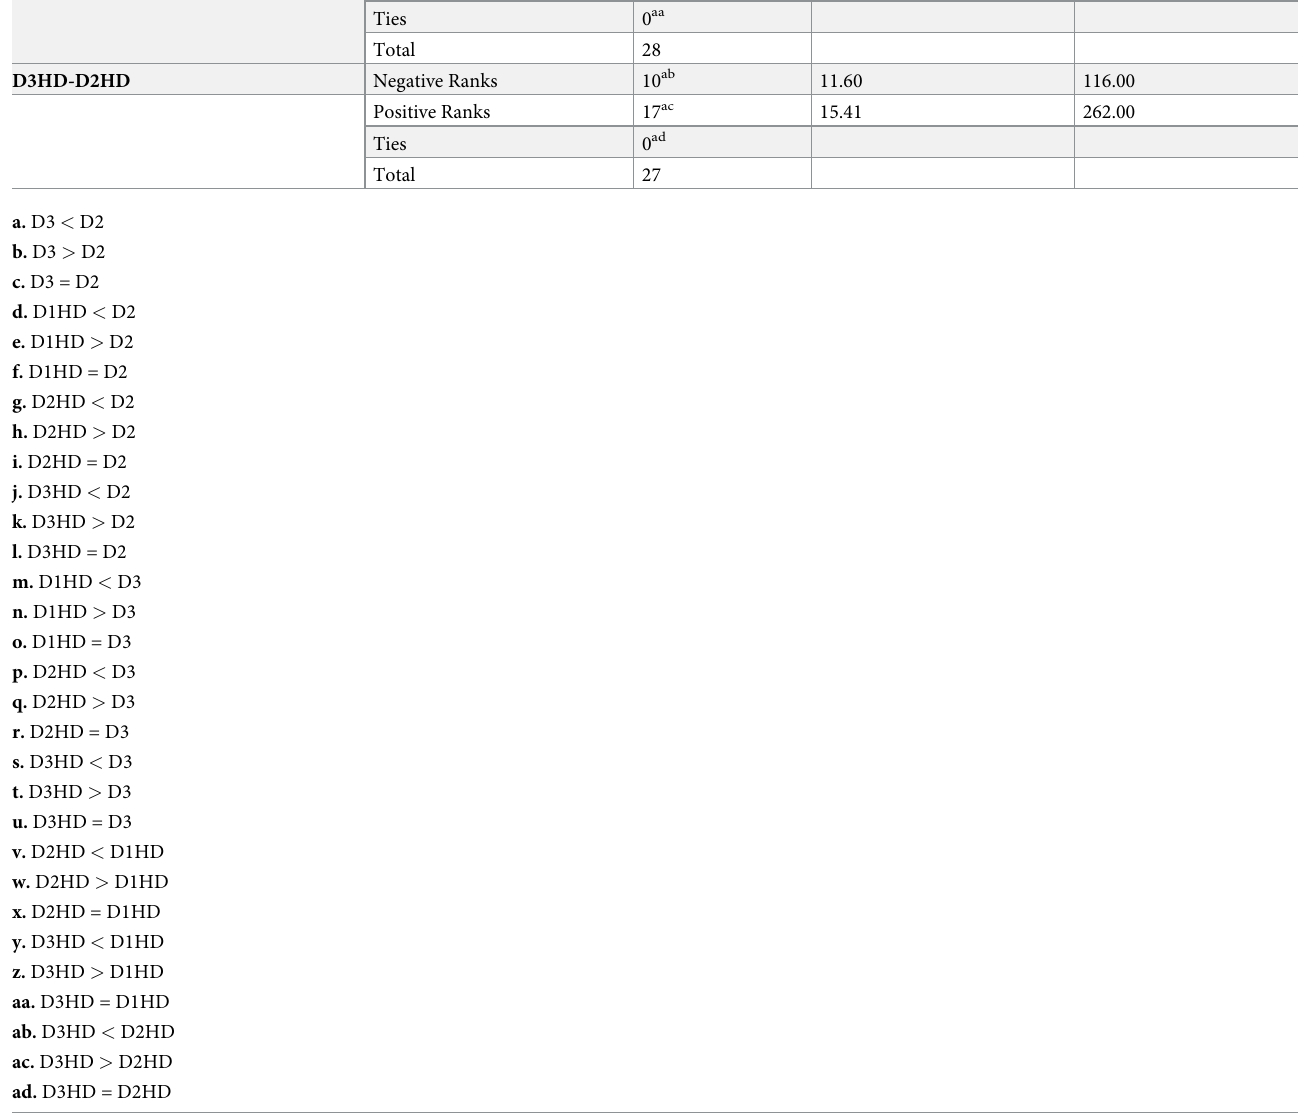
stimuli pair (Z = 2.017; p < 0.05), D2HD average solving time was faster by 1:32 than D2. In case of D3HD-D3 (Z = 2.017; p < 0.05) by 0:34. The study has also demonstrated other signifi- cant differences between variants. For the stimuli pair D1HD-D2 (Z = 2.401; p < 0.05), D1HD average solving time was faster by 1:28 than D2. In the case of D3HD-D2 pair (Z = 2.312; p < 0.05), by 1:05. Comparison of solving times for D3, D2HD and D1HD showed trend towards significance: D2HD average solving time was lower by 01:01 than D3 (Z = 1.888; p = 0.059) and D1HD on average lower by 0:58 than D3 (Z = 1.939; p =